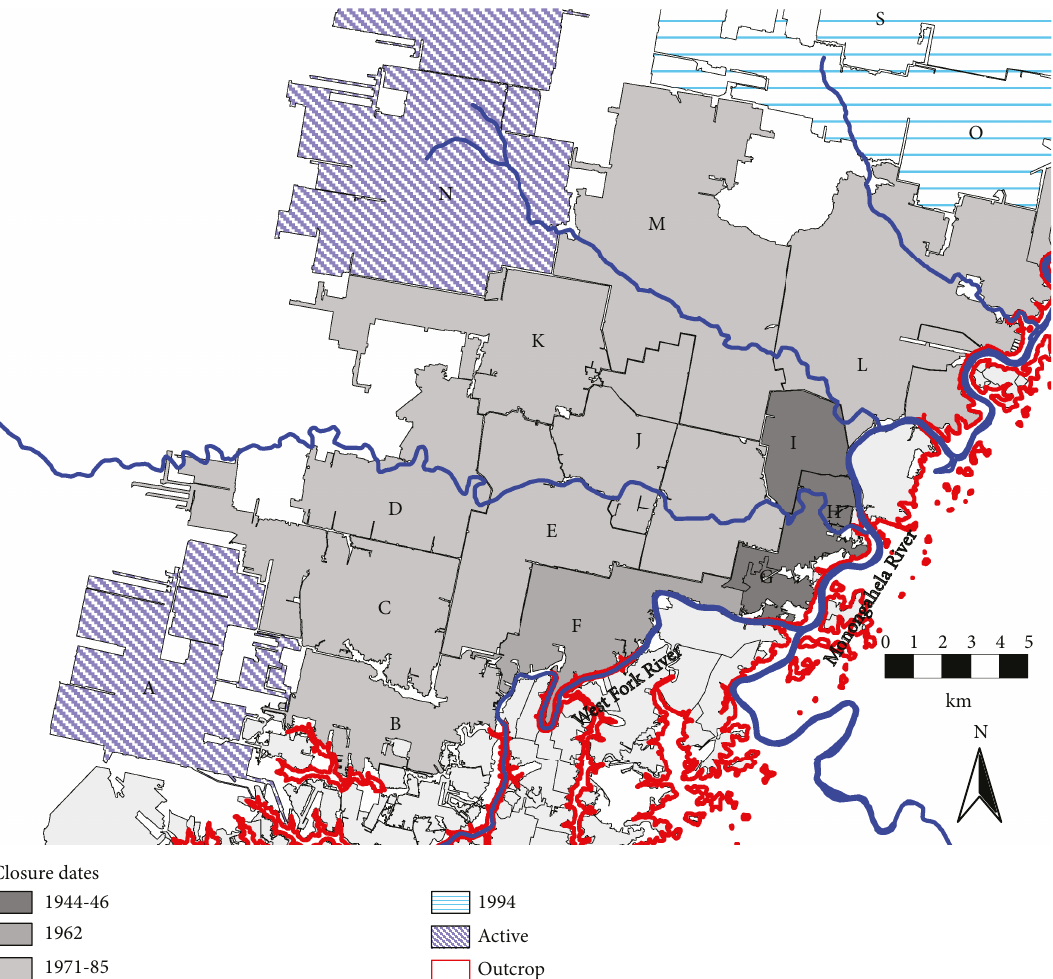
Figure 5: Mine closure chronology showing approximate dates of mine closures. Pale grey polygons north and south of the West Fork River are updip mines in shallow cover near the